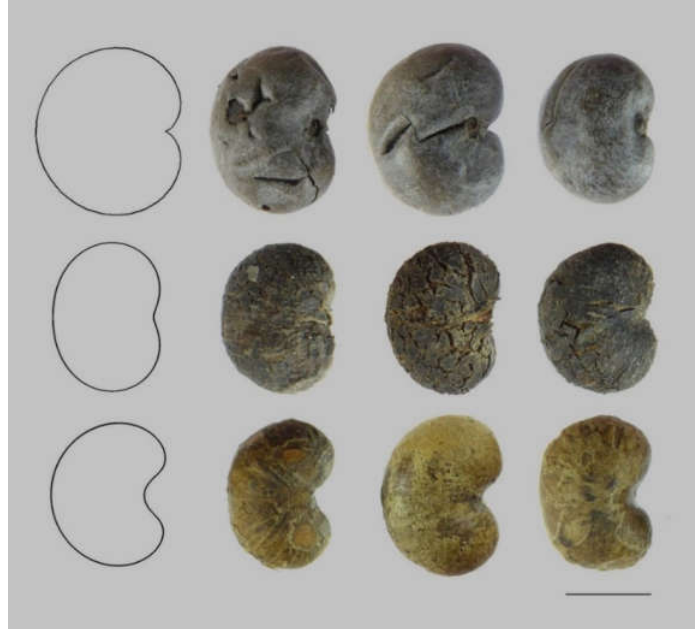
Figure 11. T. fortunei (between parenthesis values of J index with the respective model). Top: Cardioid and images of three fruits (90.4). Middle row: Modified cardioid (flattened) and images of three fruits without exocarp (the outer, visible layer is the mesocarp) (92.1). Bottom row: Modified cardioid (open) and three seeds covered only by the endocarp (exocarp and mesocarp have been removed) (91). Bar represents 0.5